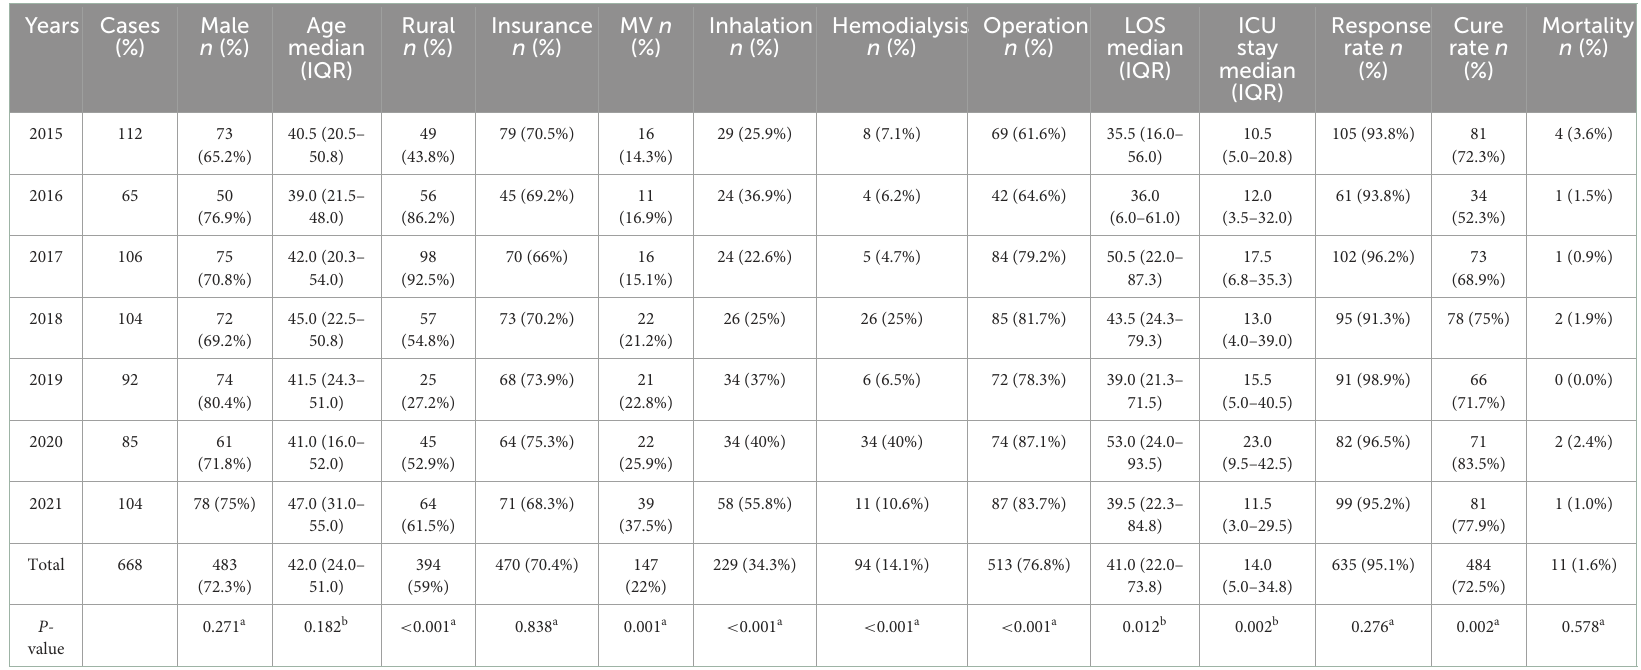
TABLE 1 Characteristics of the study population between 2015 and